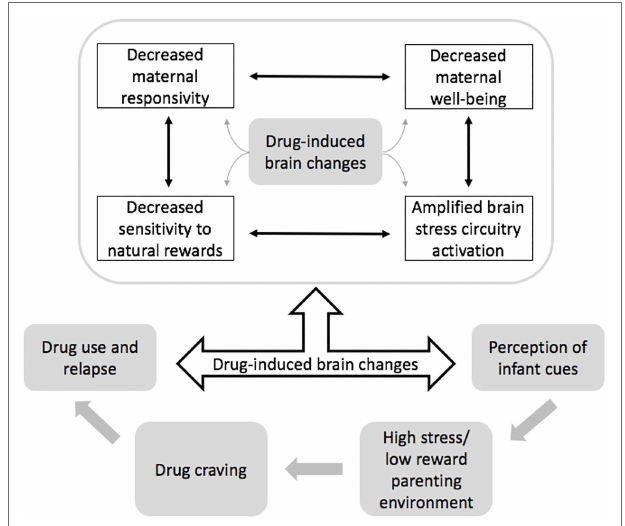
FIGURE 1 | Role of brain changes in the relationship between drug use and parenting (adapted from Rutherford et al., 2011). Drug use causes many brain changes (gray), which can influence each other (black) by amplifying/ diminishing alterations depending on